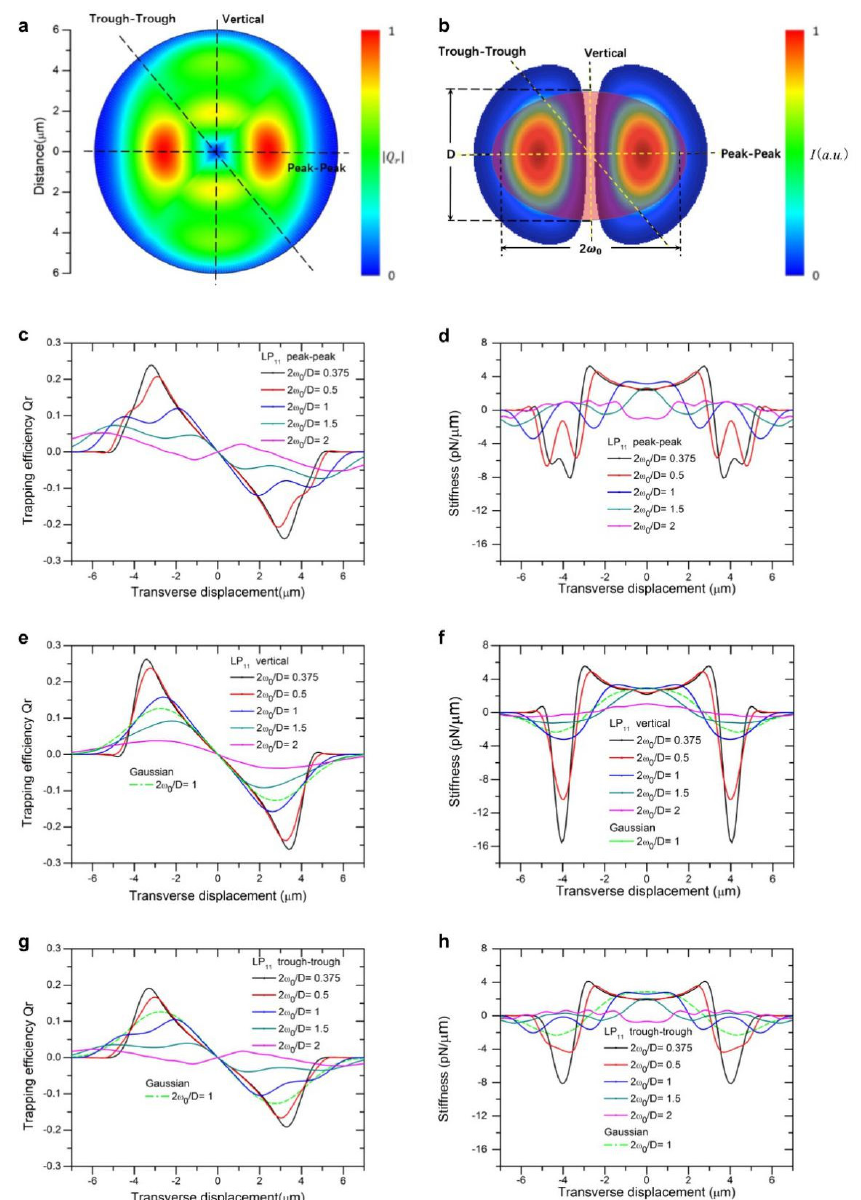
Figure 1. Landscape of trapping force of an LP 11 beam. ( a ) Normalized two-dimensional (2D) trapping force distribution of LP 11 mode; ( b ) Cross-sectional view of a spheroid cell trapped by an LP 11 beam; ( c ) LP 11 beam trapping efficiency vs. displacement curves along the peak-to-peak direction; ( d ) LP 11 beam trapping stiffness vs. displacement curves along the peak-to-peak direction. ( e ) LP 11 beam trapping efficiency vs. displacement curves along the vertical direction; ( f ) LP 11 beam trapping stiffness vs. displacement curves along the vertical direction; ( g ) LP 11 beam trapping efficiency vs. displacement curves along the trough-to-trough direction; ( h ) LP 11 beam trapping stiffness vs. displacement curves along the trough-to-trough direction.